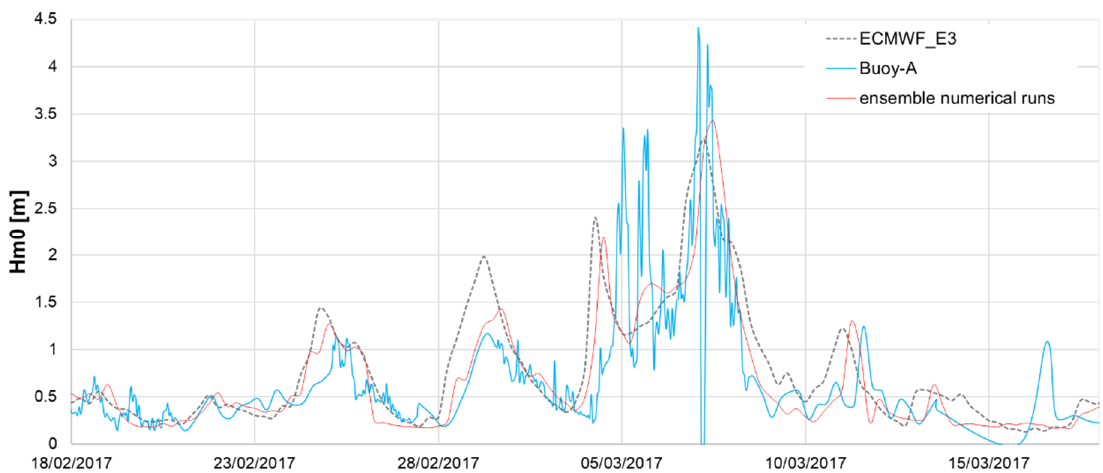
Figure 14. Comparison of time series obtained with the ensemble numerical runs, buoy records at MEDA A and ECMWF data for the reference point E3.